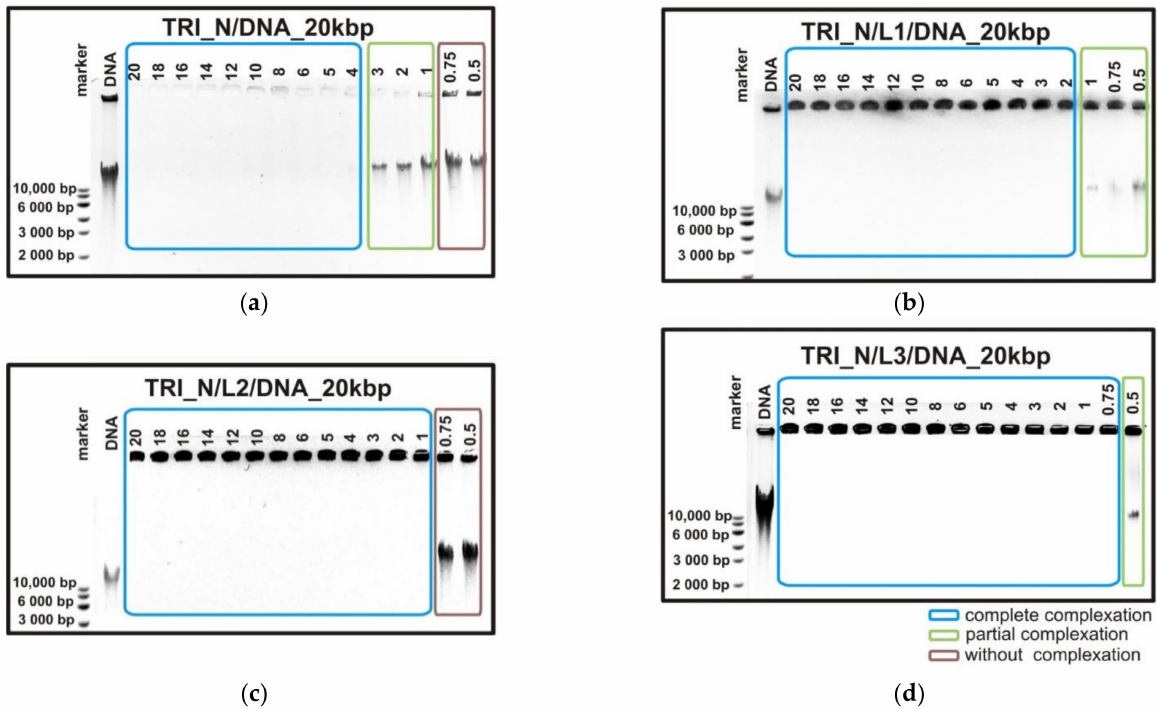
Figure 1. Agarose gel electrophoresis results obtained for lipoplexes based on high-molecular-weight DNA consisting of 20 kbp and ( a ) TRI_N, ( b ) TRI_N/L1, ( c ) TRI_N/L2, and ( d ) TRI_N/L3